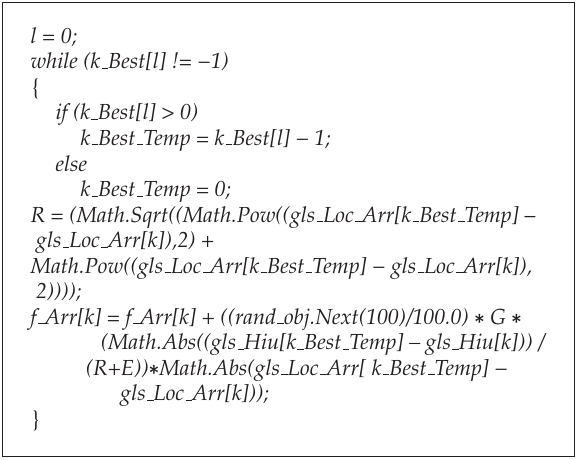
Algorithm 3: Calculating R and